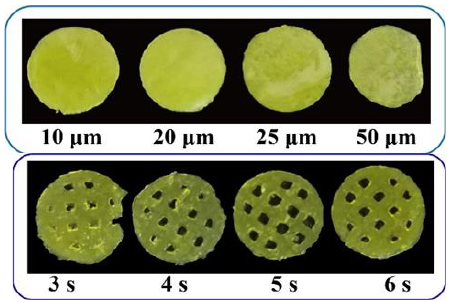
Figure 7. Pictures of 3D-printed oral films with different printing parameters.